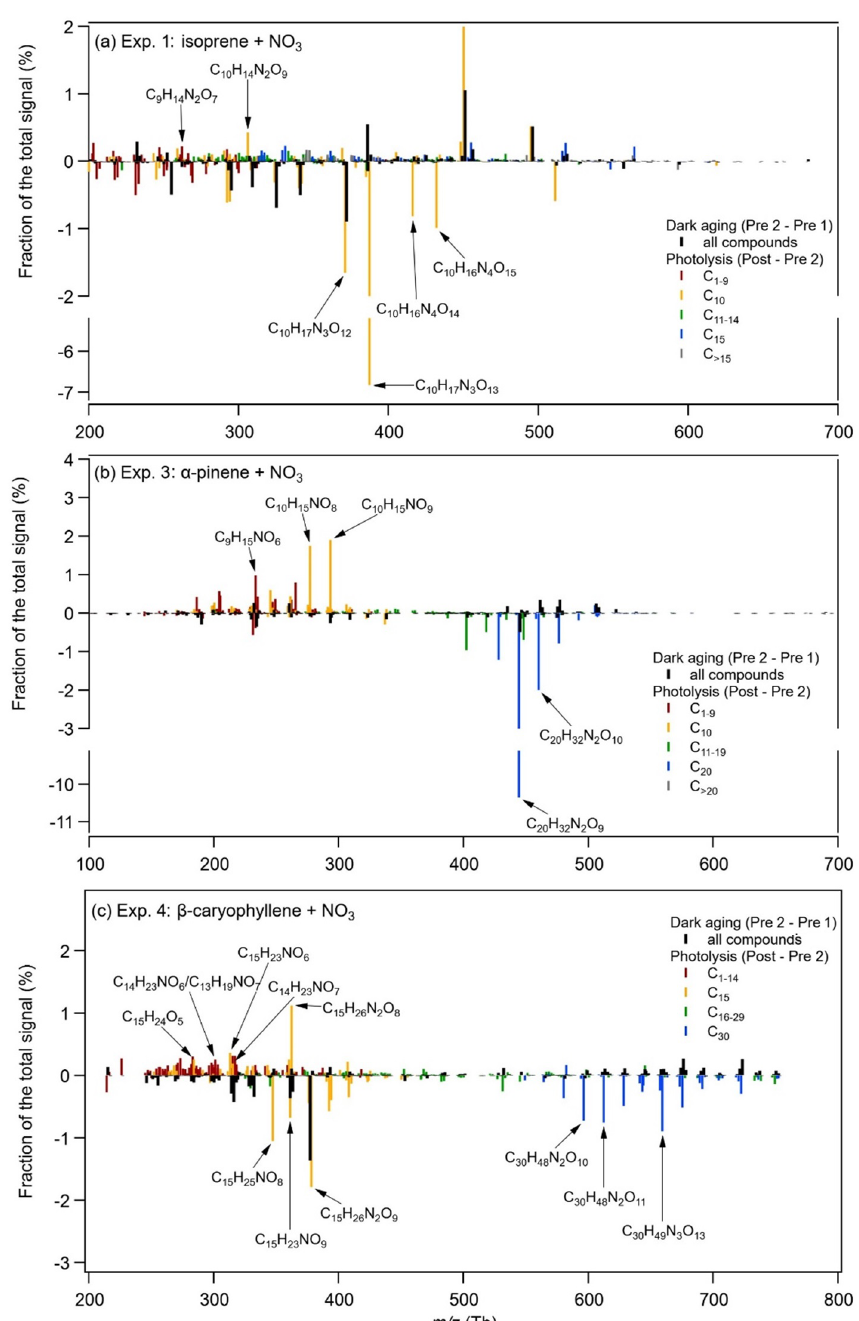
Figure 3. Relative changes in the fraction of the total signal between two filters during dark ageing (Pre 2 – Pre 1) and between the last filter during dark ageing and the filter after 1h of photolysis (Post – Pre 2) for (a) Exp. 1 (isoprene + NO 3 ), (b) Exp. 3 ( α -pinene + NO 3 ), and (c) Exp. 4 ( β -caryophyllene + NO 3